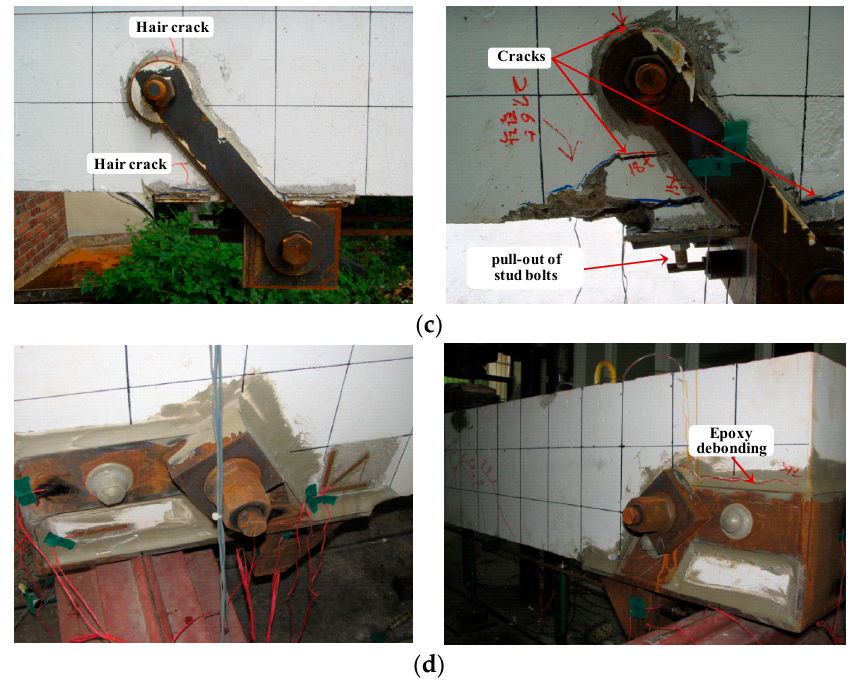
Figure 4. Failure modes of tested beams. ( a ) LHS; ( b ) LHT; ( c ) LHU and ( d ) JBM series.